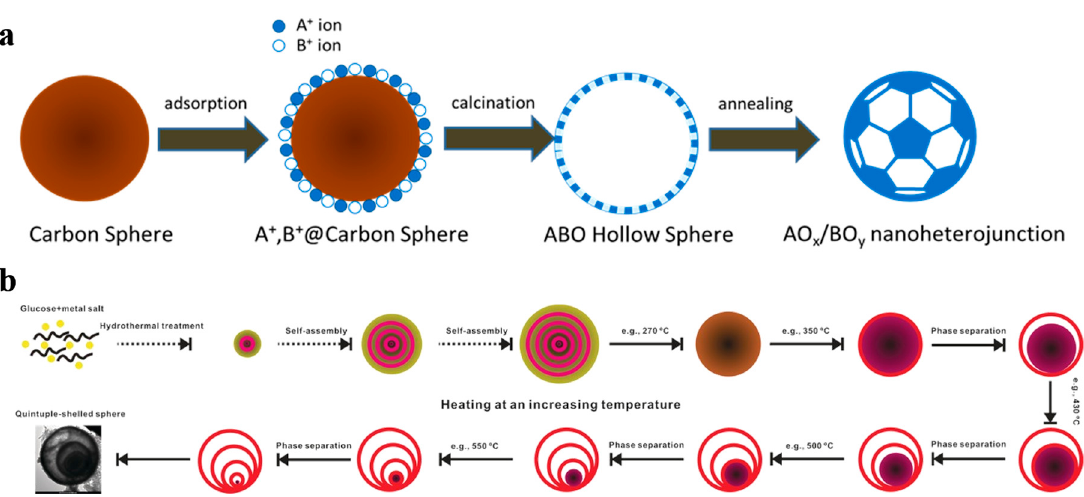
Figure 3. General process for the formation of carbon sphere template derived ( a ) hollow nanoheterostructure and ( b ) controllable multilayer structure. Reproduced with permission from [47]. Copyright WILEY, 2016.